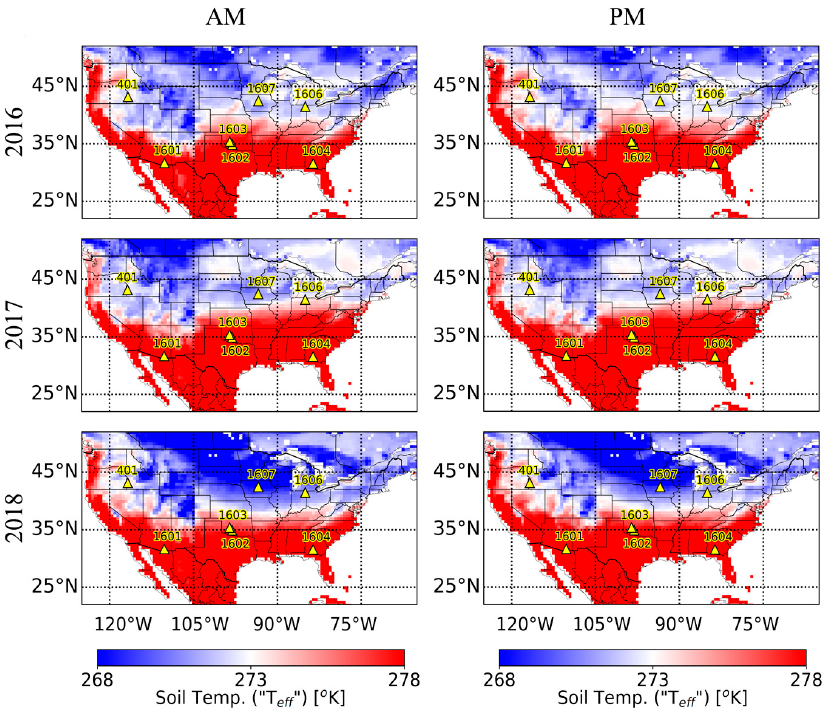
Figure 10. Map of the effective soil temperature (T eff ), averaged for January and February for 2016 to 2018. Study sites are identified using yellow triangles.